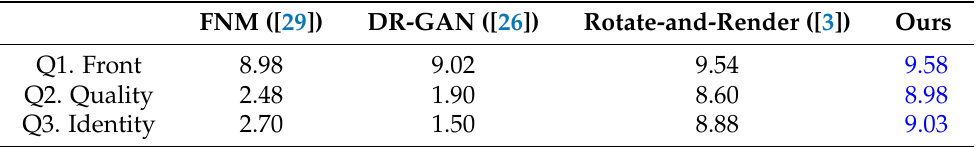
Table 4. The results of our user study. The answers are averaged from 10 images in Figure 12 from 50 participants. The blue figures in each row are the best